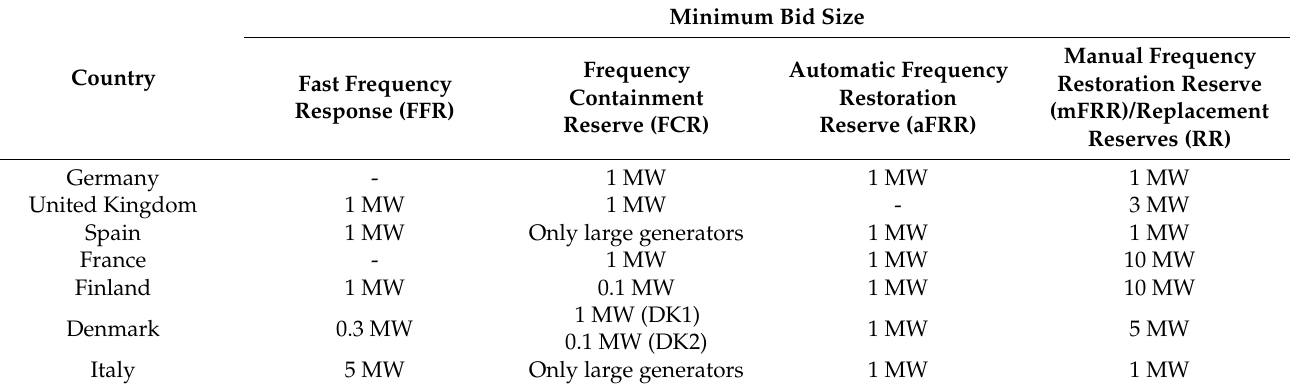
Table 1. Minimum bidding size required to provide frequency control by DERs in the countries